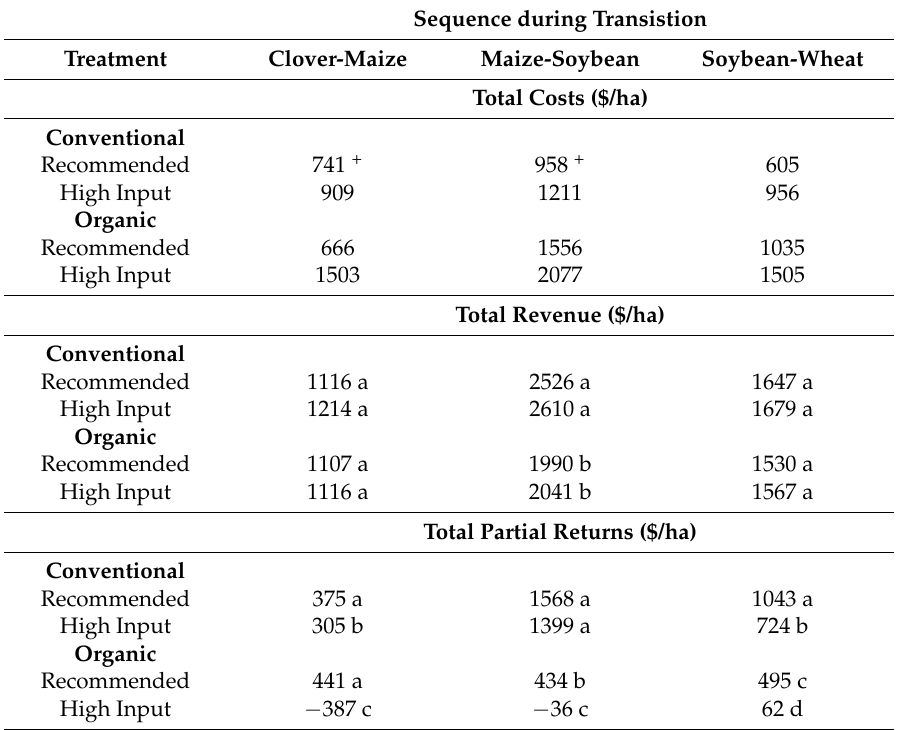
Table 10. Estimated partial returns of three rotations (red clover-maize, maize-soybean, and soybean-wheat) during the transition period (2015 and 2016) in conventional and organic cropping systems with recommended and high input management in central New